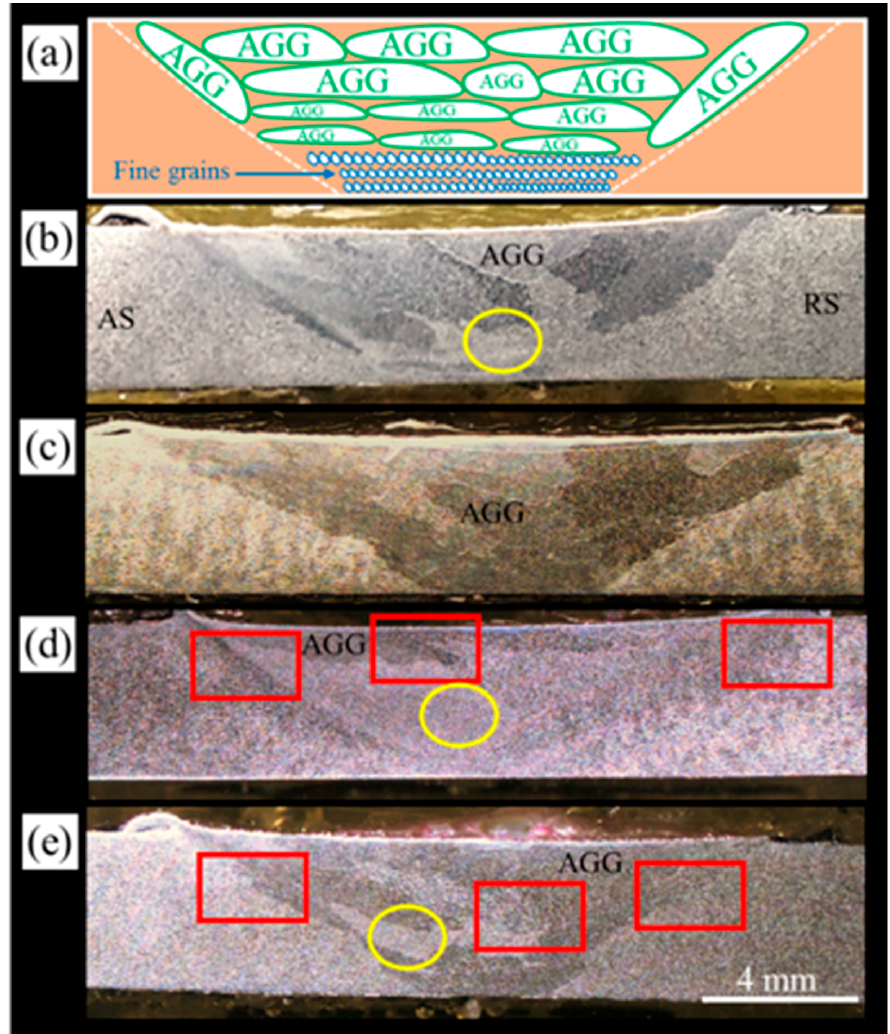
Figure 6. Macro photos of PWHT Al6061(T6) samples: ( a ) Schematic of weld cross-section, ( b ) Sample A-1 (PWHT), ( c ) Sample A-4 (PWHT), ( d ) Sample C-1 (PWHT), and ( e ) Sample C-4 (PWHT) (marks show the area for detailed microstructure observation).